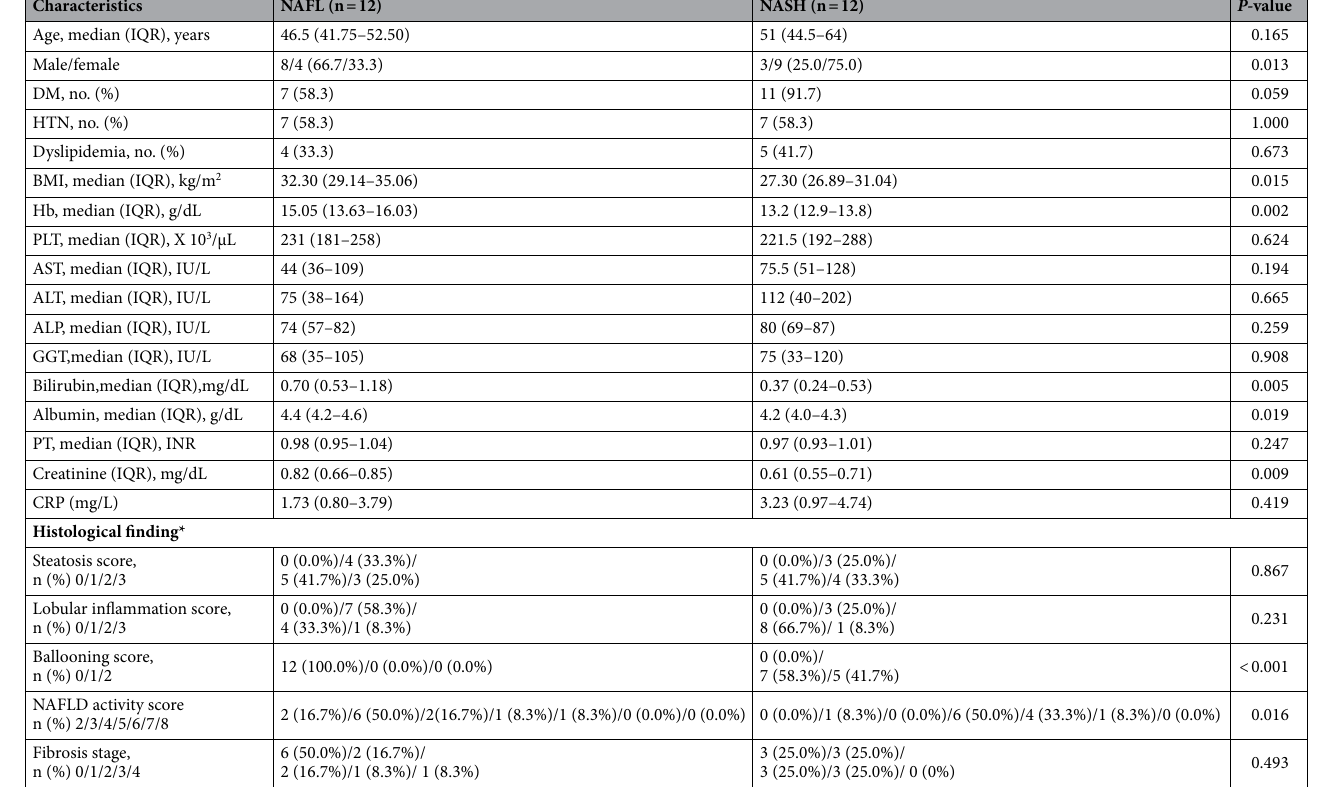
Table 1. Baseline characteristics. NAFL nonalcoholic fatty liver, NASH nonalcoholic steatohepatitis, IQR interquartile range, BMI body mass index, DM diabetes mellitus, HTN hypertension, Hb hemoglobin, PLT platelet, AST aspartate transaminase, ALT alanine transaminase, ALP alkaline phosphatase, PT prothrombin time, INT international normalized ratio, GGT gamma glutamyl transferase, CRP C-reactive protein. *Histological findings were analyzed based on NAFLD activity scores developed by NASH clinical research